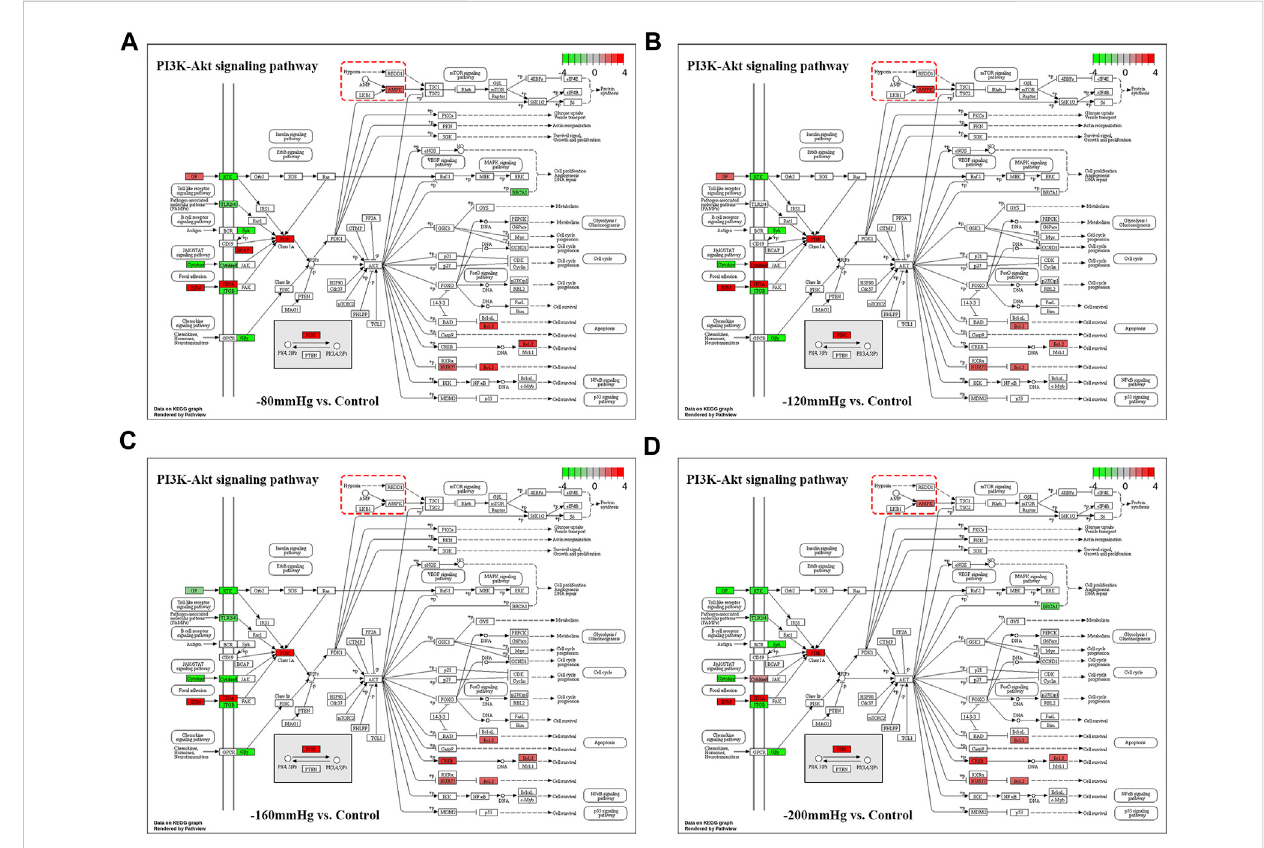
FIGURE 12 PI3K-Akt signaling pathway in − 80mmHg vs. Control (A) , − 120mmHg vs. Control (B) , − 160mmHg vs. Control (C) and − 200mmHg vs. Control (D)